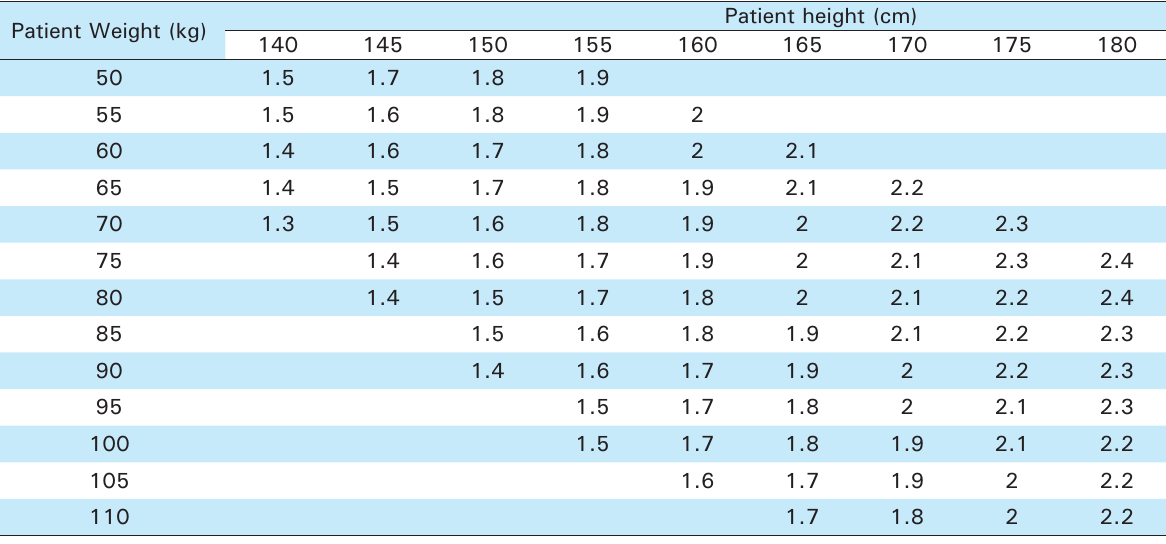
Table1. Adjusted dose regimen for hyperbaric bupivacaine 0.5 % for caesarean section under spinal anesthesia (values are in milliliters) 8 Patient Weight